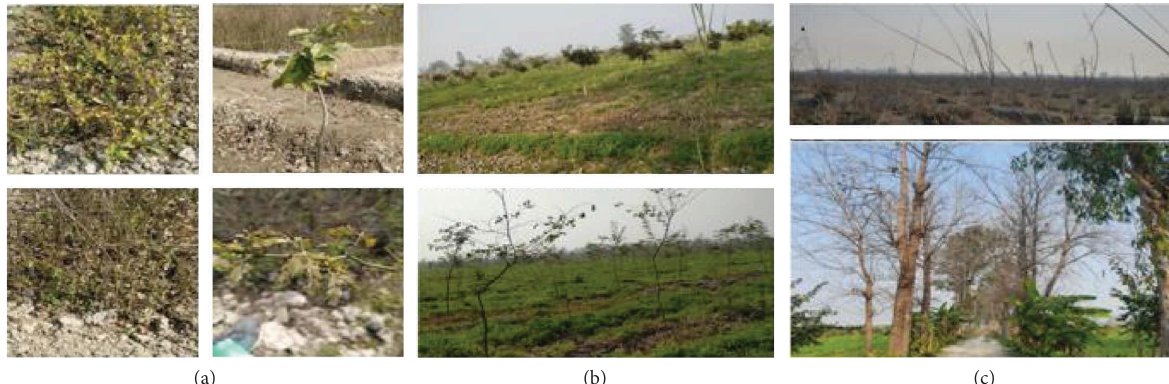
Figure 4: Plantation at diferent sites of Parikshitgarh. (a) Ganga river site. (b) First block. (c) Second block.